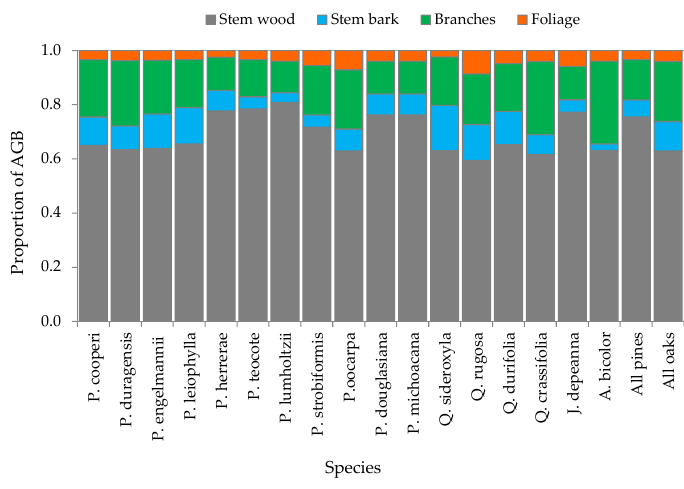
Figure 3. Estimated relative contributions of the biomass components to total tree above ‐ ground biomass (AGB) for pine and oak species in Durango state, Mexico.